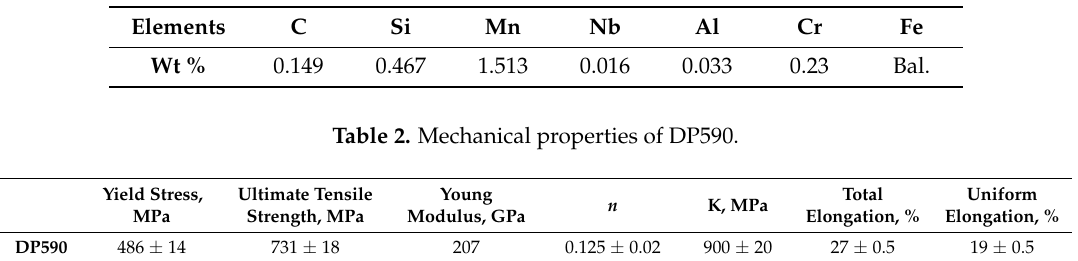
Table 1. Chemical compositions (Wt %) of DP590.